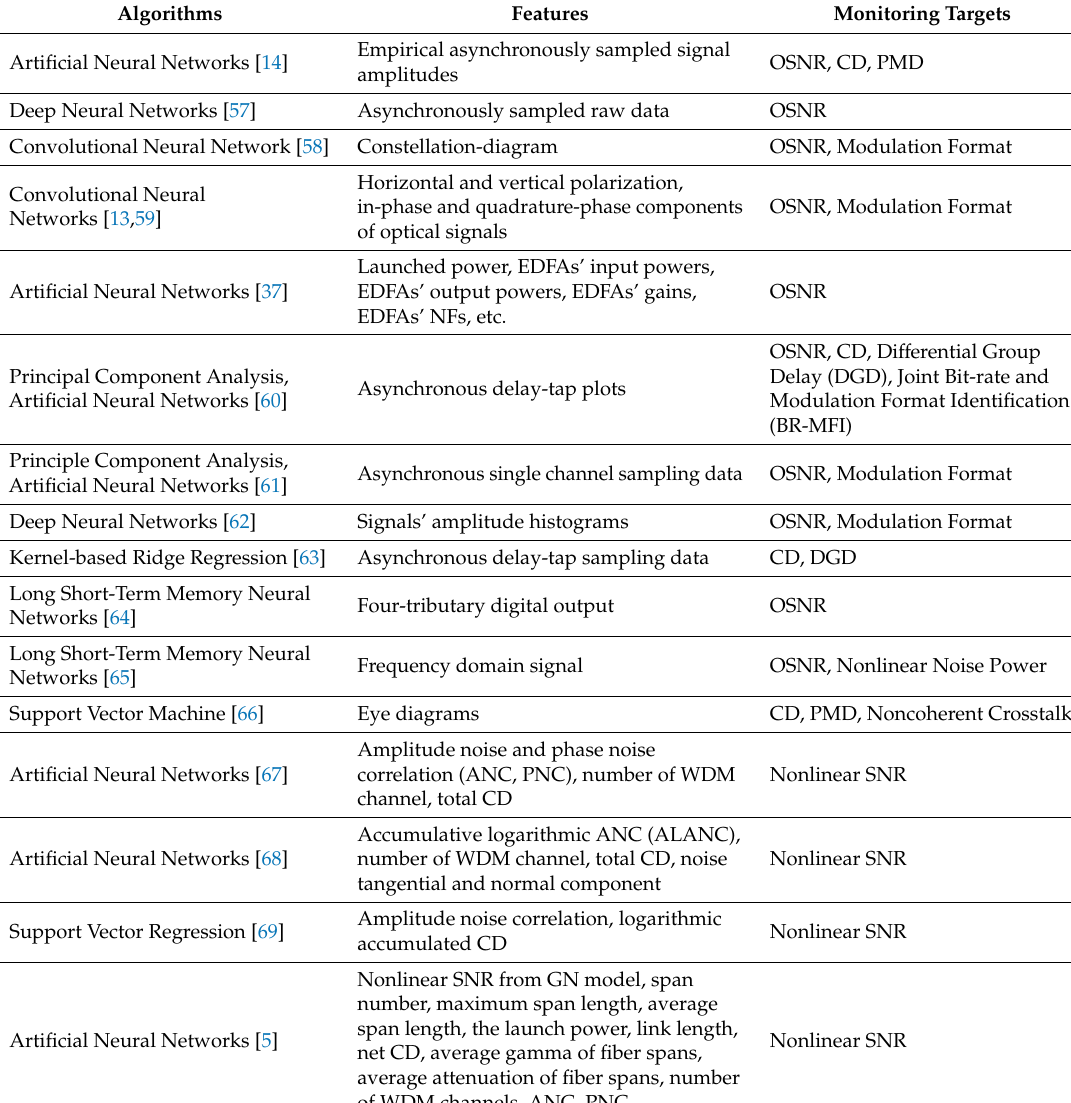
Table 3. Summary of the ML-based monitoring techniques discussed in Section